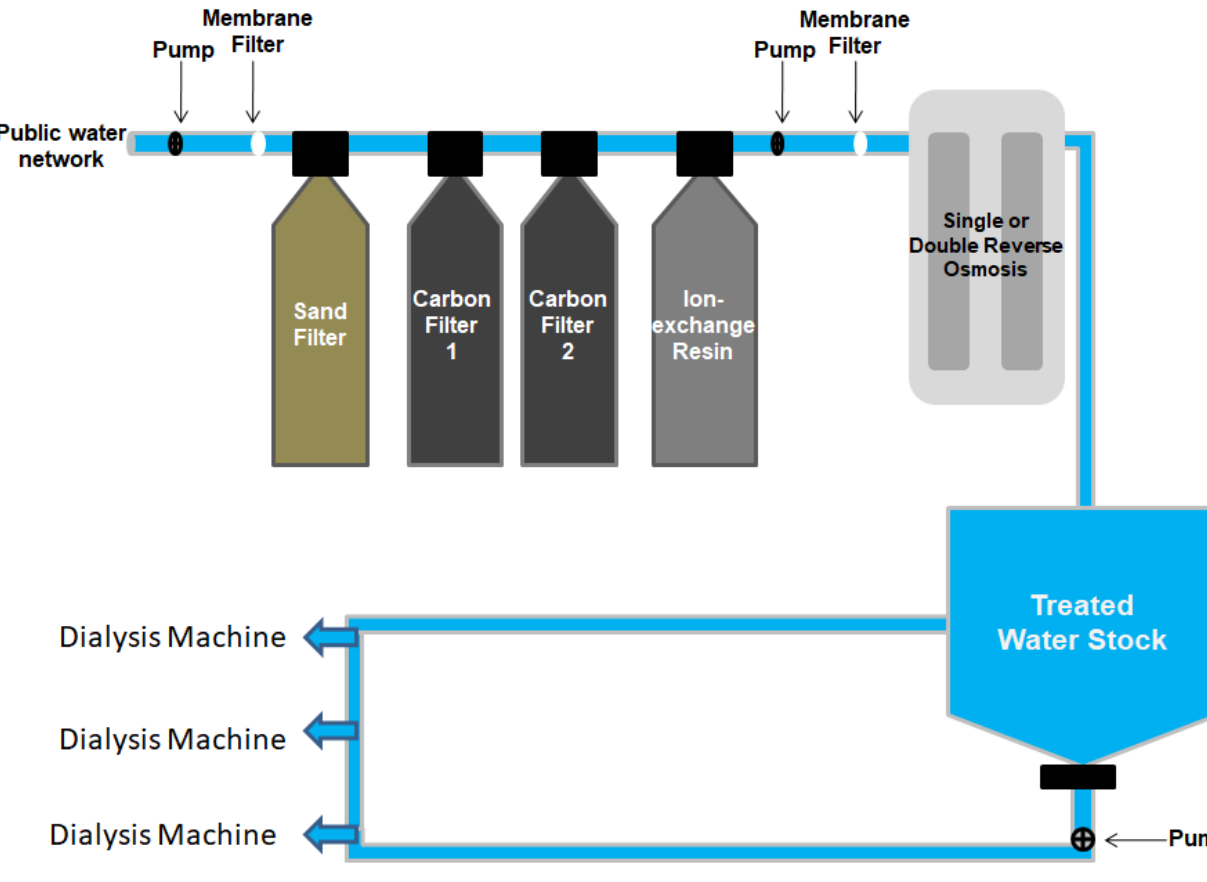
FIGURE 3 - Dialysis water treatment